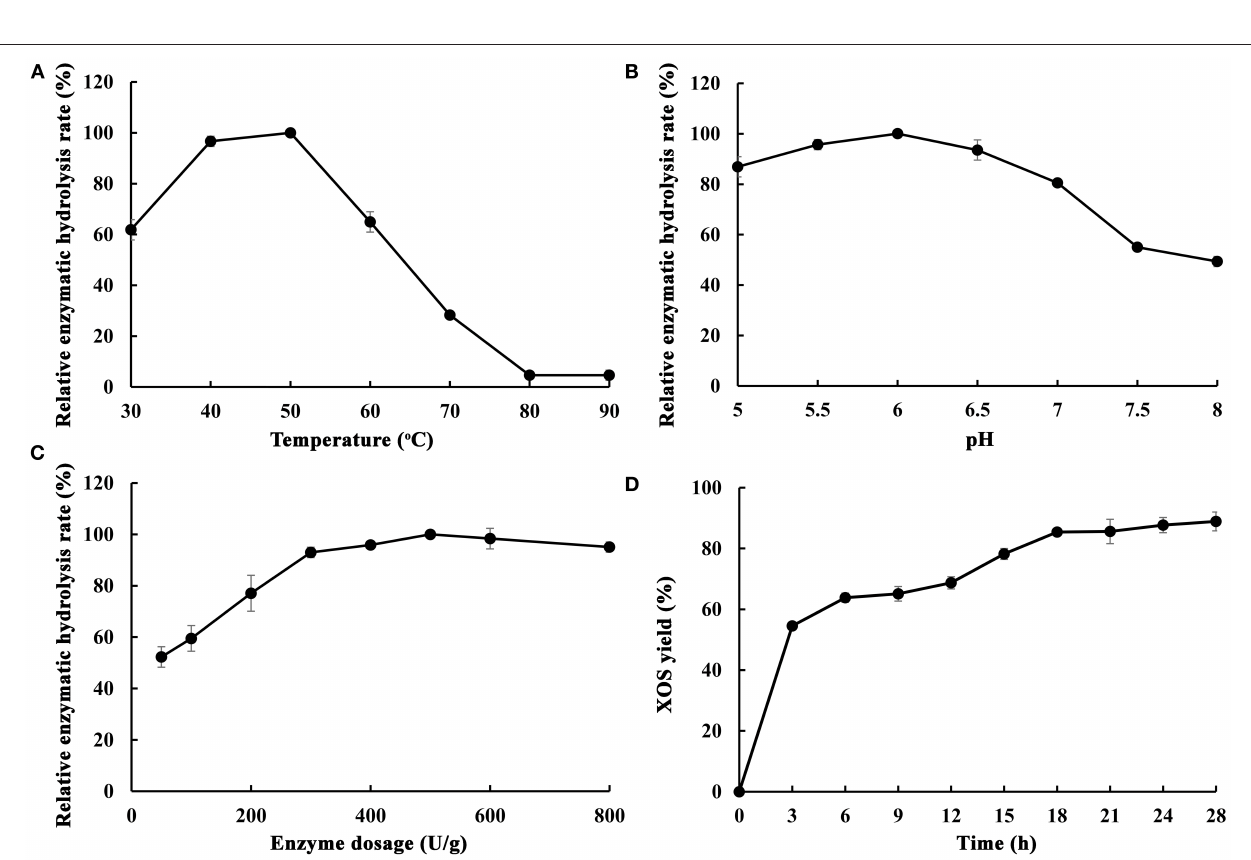
FIGURE 5 | Optimization of different enzymatic hydrolysis conditions of poplar sawdust xylan by recombinant endo-1,4- β -xylanase MxynB-8 [ (A) The effect of temperature on the enzymatic hydrolysis rate; (B) The effect of pH on the enzymatic hydrolysis rate; (C) The effect of enzyme dosage on the enzymatic hydrolysis rate; (D) The effect of time on the enzymatic hydrolysis rate]. The maximum hydrolysis rate measured at a certain temperature/pH/enzyme dosage was defined as relative 100%.